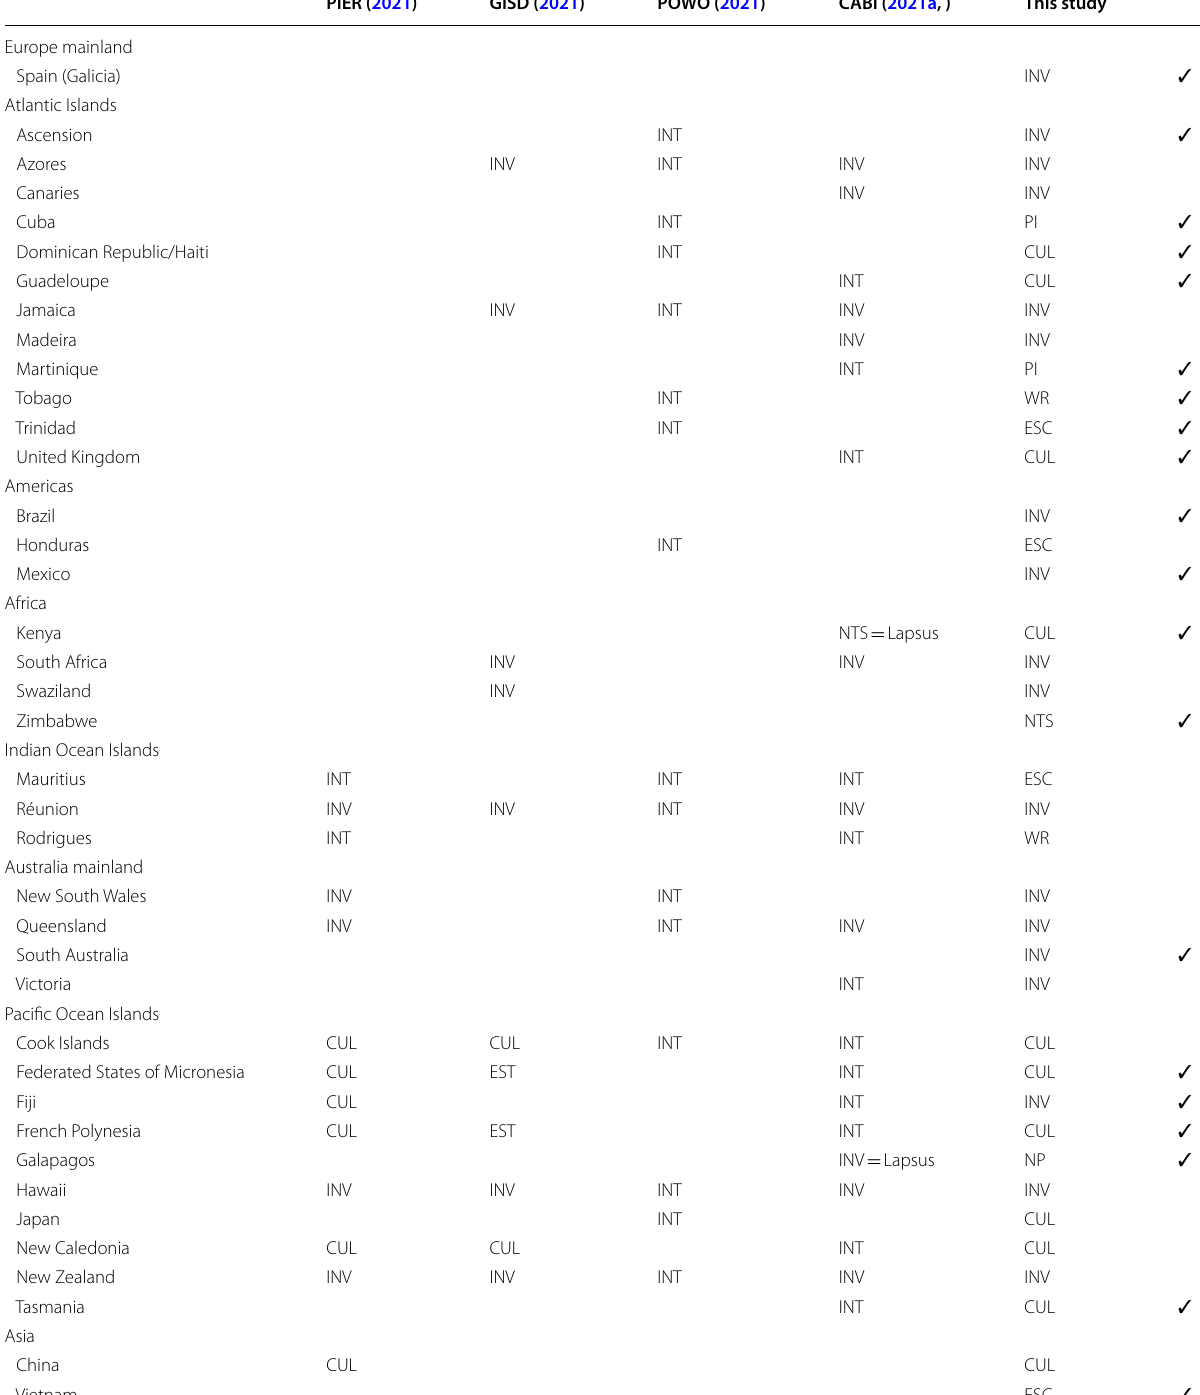
Table 5 Hedychium gardnerianum distribution on the PIER, GISD, POWO and CABI databases and the present update proposal